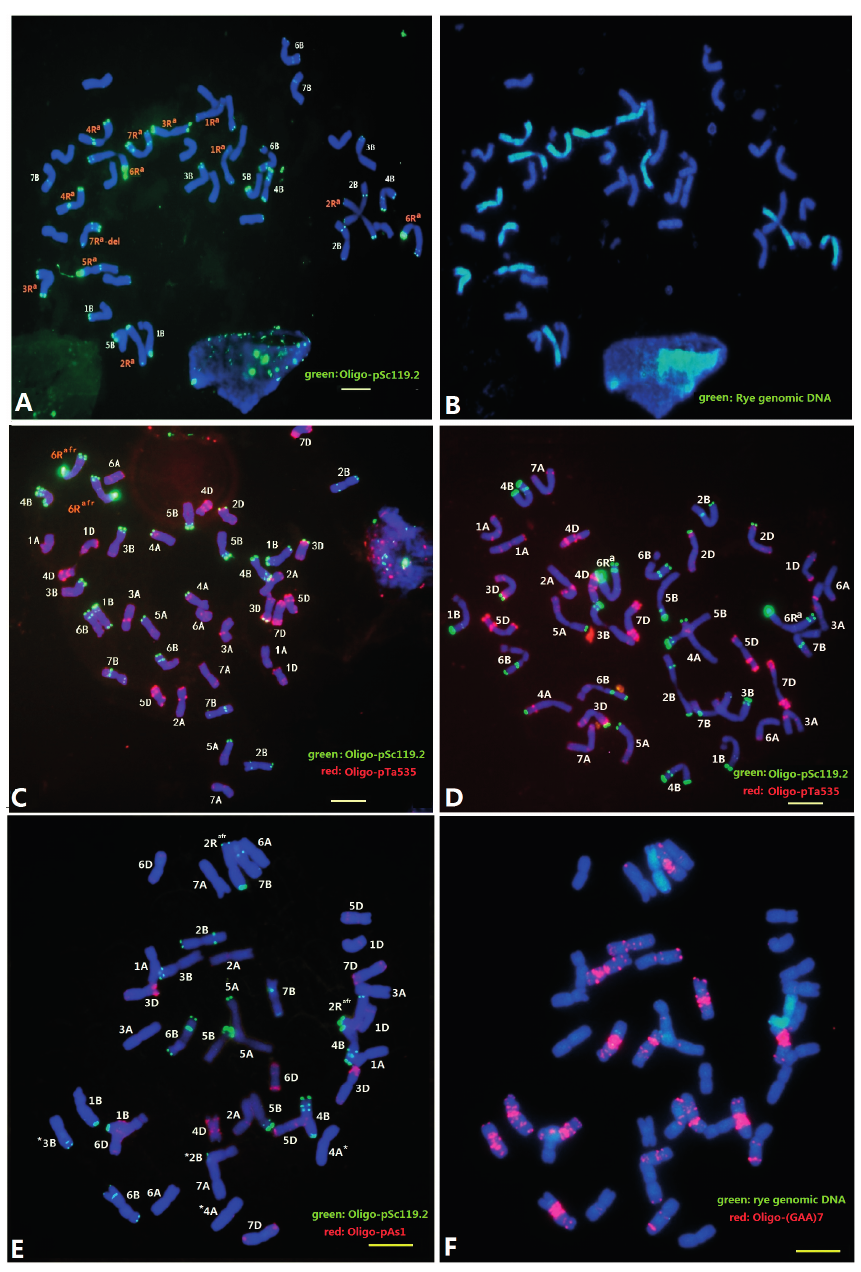
Figure 1. FISH and genomic in situ hybridization of T. durum — S. africanum amphiploid ( A , B ); T. aestivum — S. africanum chromosome 6R afr (6D) substitution lines HH-41 ( C ); Mn512 ( D ); and 2R afr (2D) substitution line LF34 ( E , F ). The bar is 10 μ